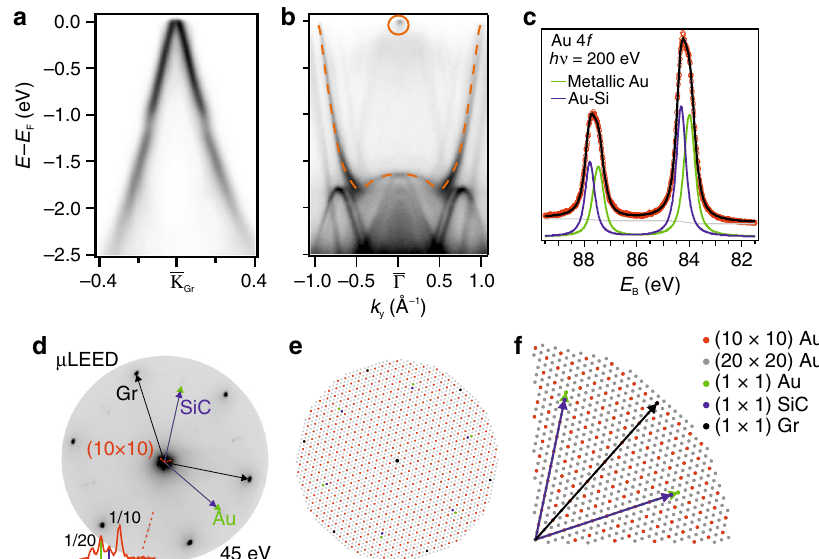
Fig. 3 Properties of the p -phase Au-intercalated graphene. a ARPES spectrum of the graphene ’ s Dirac cone measured along k y , recorded with photons of 40 eV. b ARPES spectrum measured at 75 eV centered in (cid:2) Γ , showing the band structure of the intercalated gold along the k y direction. c μ XPS spectrum of Au 4 f doublet. d μ LEED pattern of the system. In the bottom-left corner the line pro fi le along the red line is shown, highlighting the four diffraction spots visible and assigning them to SiC (blue), Au (green) and the 1/20 and 1/10 Au superperiodicities. e Sketch of the μ LEED with all the periodicities indicated. f Blow-up of one quadrant of panel e